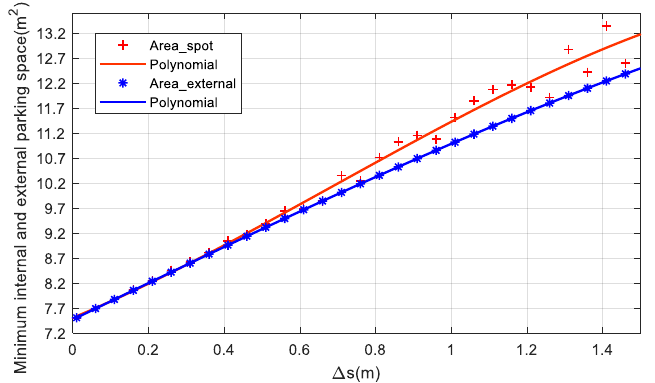
Figure 6. Variation of minimal internal and external parking space.